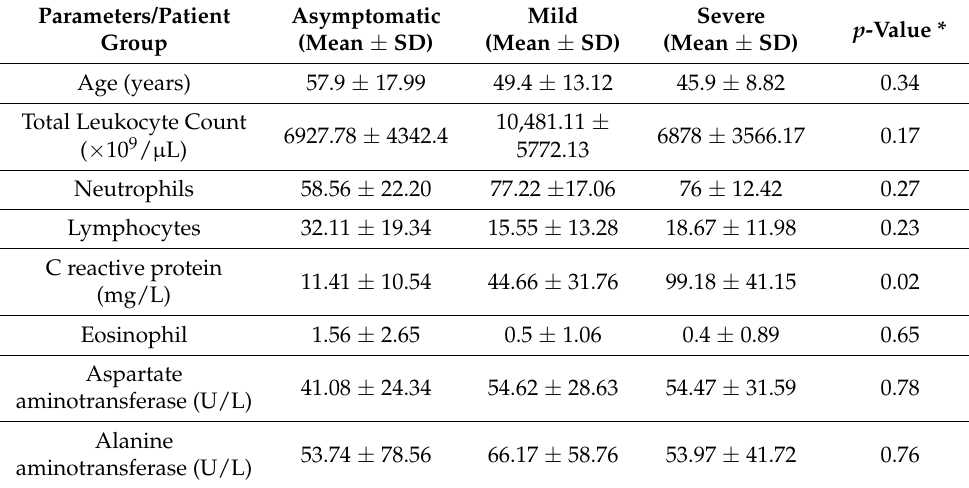
Table 1. Clinical parameters of patients at the admission stage to AIIMS, Bhopal.